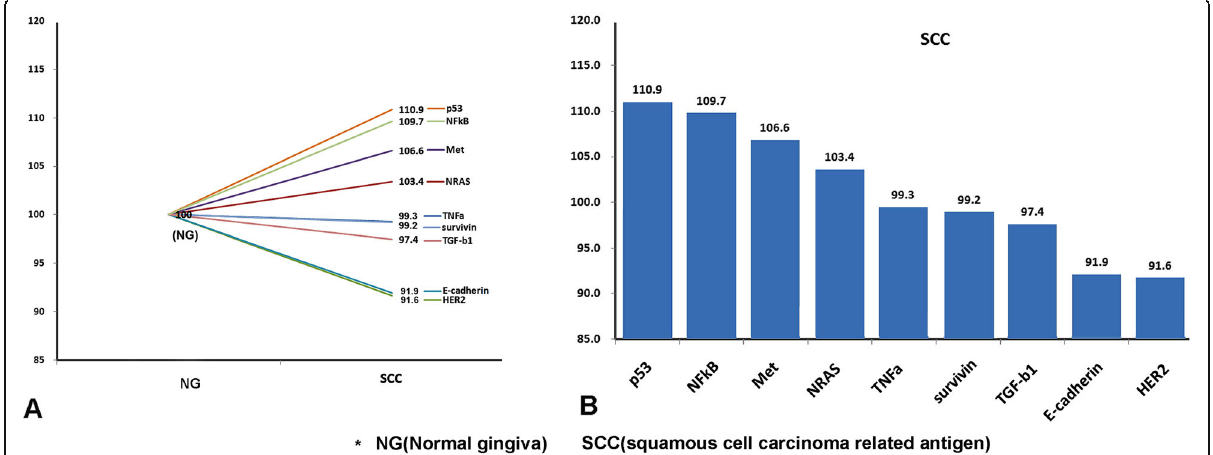
Fig. 5 A line graph ( a ) and a bar graph ( b ) comparing oncogenic protein expression profiles between normal gingiva and SCC tissue from the first ablation surgical